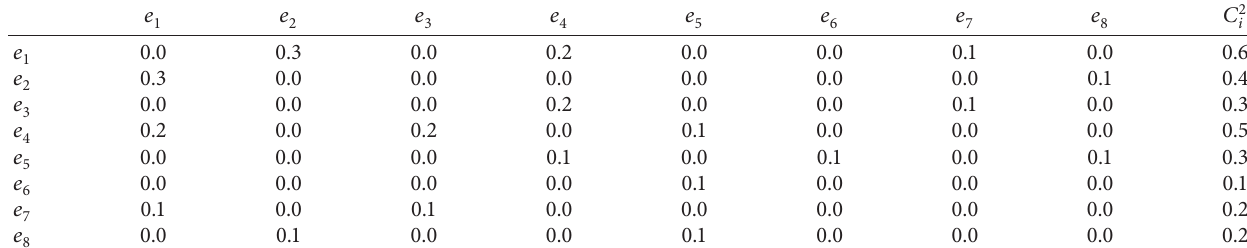
) with choice values. 2